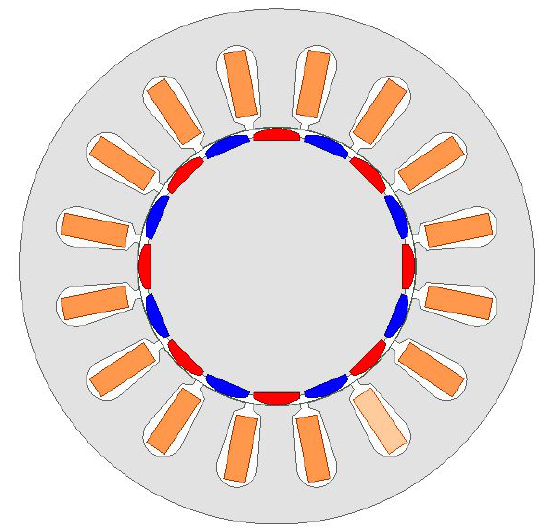
Figure 7. Cogging motor configuration with eight pole pairs.